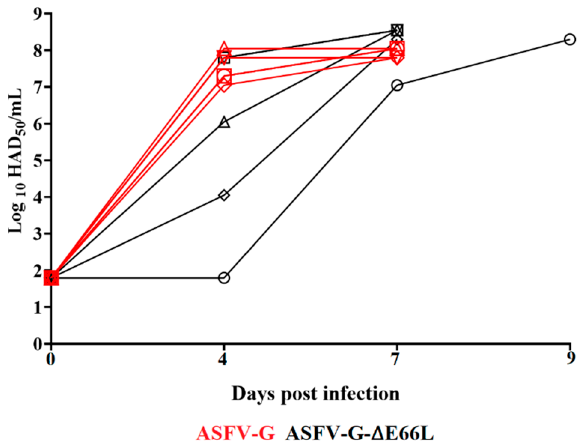
Figure 5. Viremia titers detected in pigs IM inoculated with 10 2 HAD 50 of either ASFV-G- ∆ E66L (filled symbols), or ASFV-G (empty symbols). Each symbol represents the average of animal titers in each of the groups. Sensitivity of virus detection: >log10 1.8 TCID 50 /mL. No significant differences in viremia values between both groups of pigs were found using the two-stage set-up (Benjamini, Krieger, and Yekutieli) method.